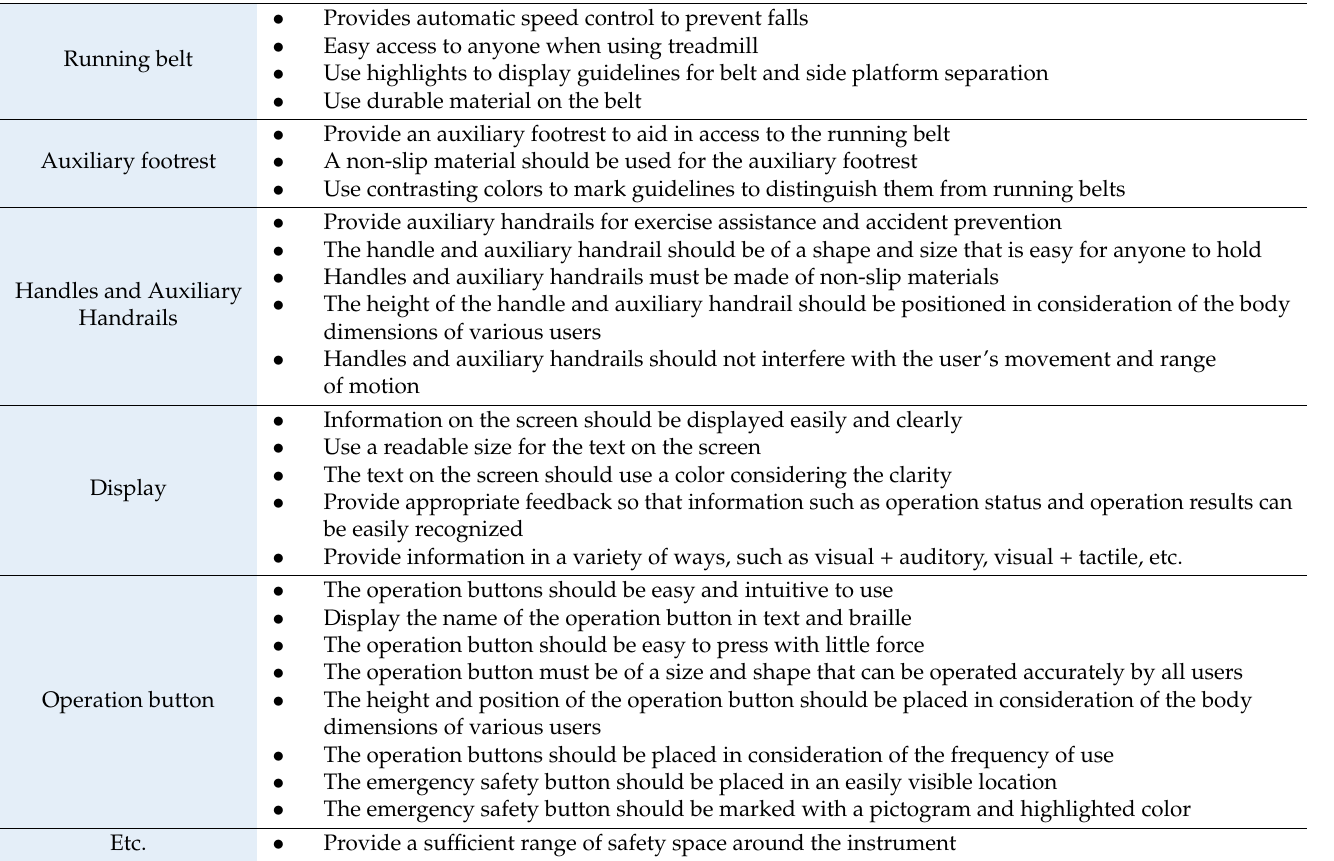
Figure 15. Second design concept of treadmill applying UD. Table 9. Treadmill guidelines with UD applied .